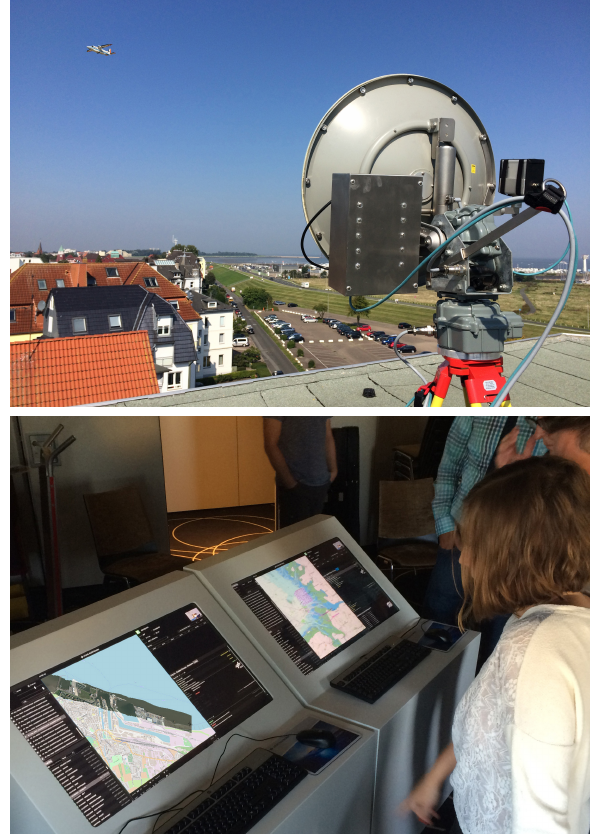
Figure 7. Real-time mapping using TAC algorithm: Aerial im- ages are captured, clipped and transmitted via a 10 MBit/s data downlink to a ground station (upper figure), where mapping software generates seamless aerial maps from the transmitted image data (lower figure). The latency between image acquisi- tion and visualization is about 2